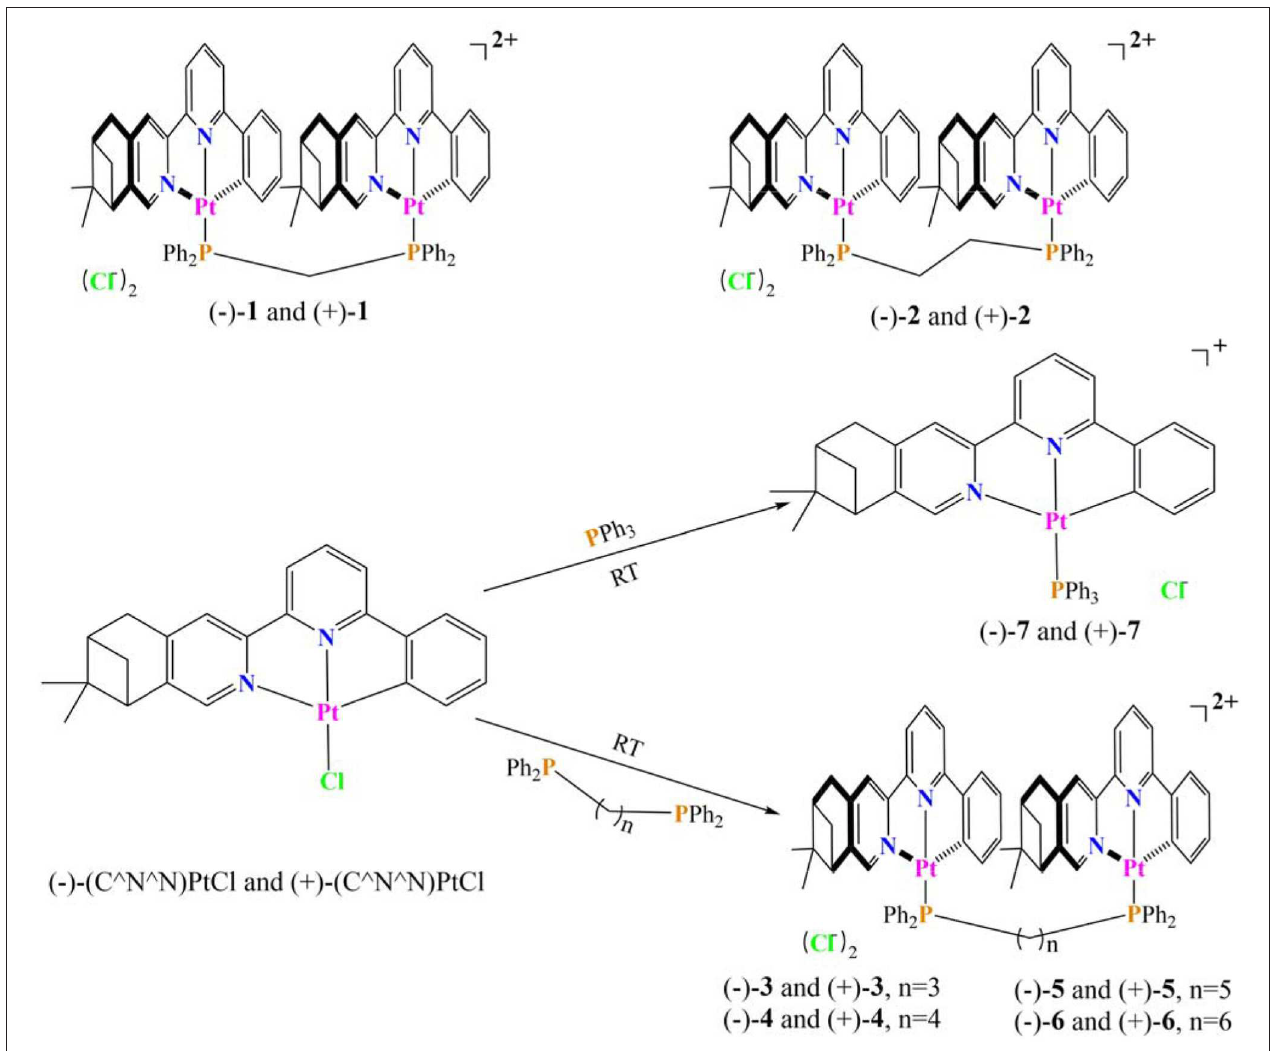
SCHEME 1 | Synthesis of dinuclear and mononuclear Pt(II)